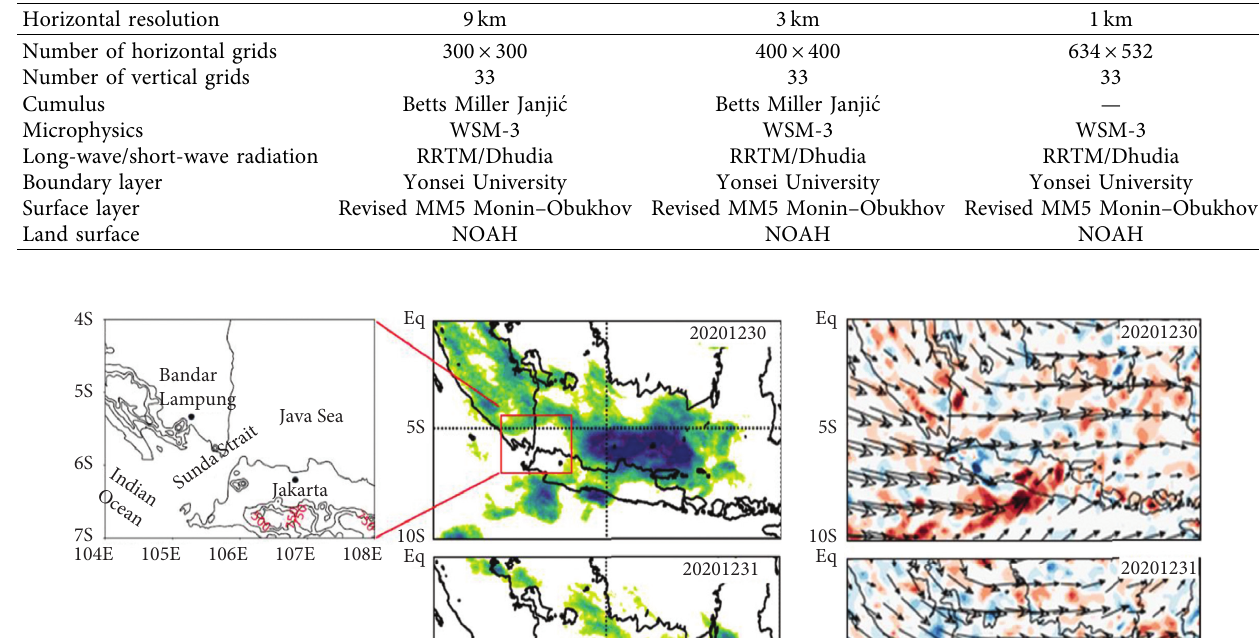
Table 1: Model configuration of WRF for simulating precipitation over the Maritime Continent with horizontal resolutions: 9 km (D01), 3km (D02), and 1 km (D03).